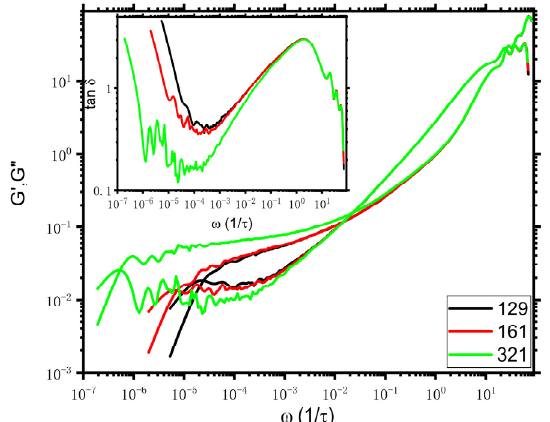
Figure 2. Viscoelastic moduli for 𝑁 = 129 , 161, and 321. The absolute values of 𝐺(𝑡) are input into i-Rheo GT to obtain the viscoelastic moduli, and the values of 𝐺(0) are 43.7, 43.7, and 43.8 for 𝑁 = 129 , 161, and 321, respectively. The tan 𝛿 vs. frequency is presented in the inset.